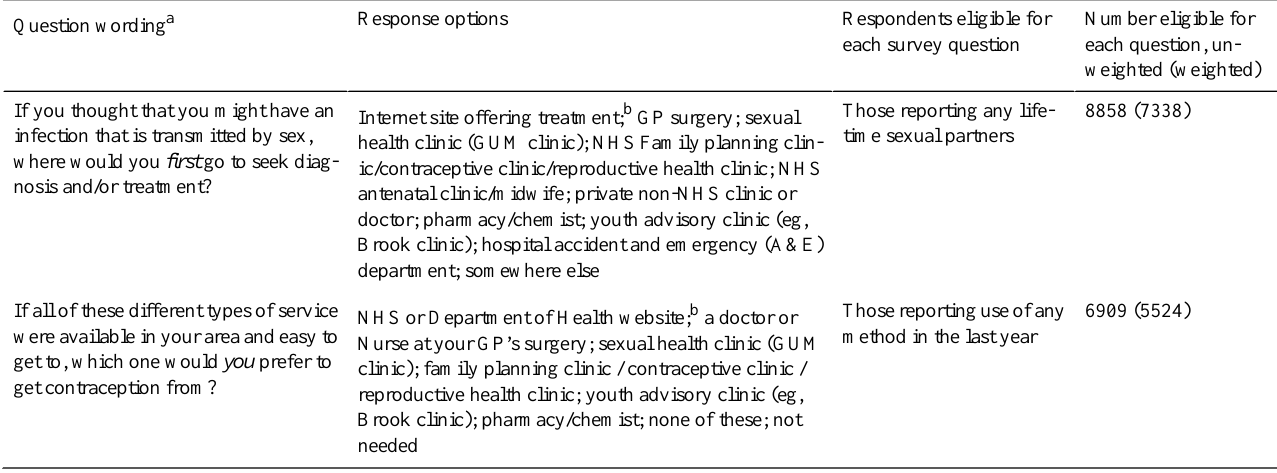
Table 2. Natsal-3 survey questions about preferred sources of sexual health care.